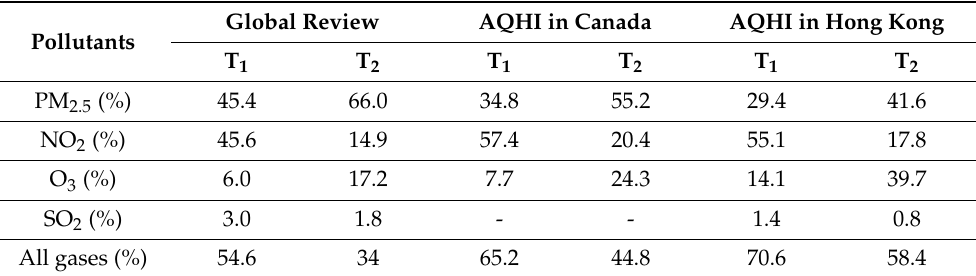
Table 2. A comparison of the fractions of the %AR for the four air pollutants at two pollution peaks (i.e., T 1 and T 2 ) using the three sets of β coefficients (i.e., from global review and the AQHI systems of Canada and Hong